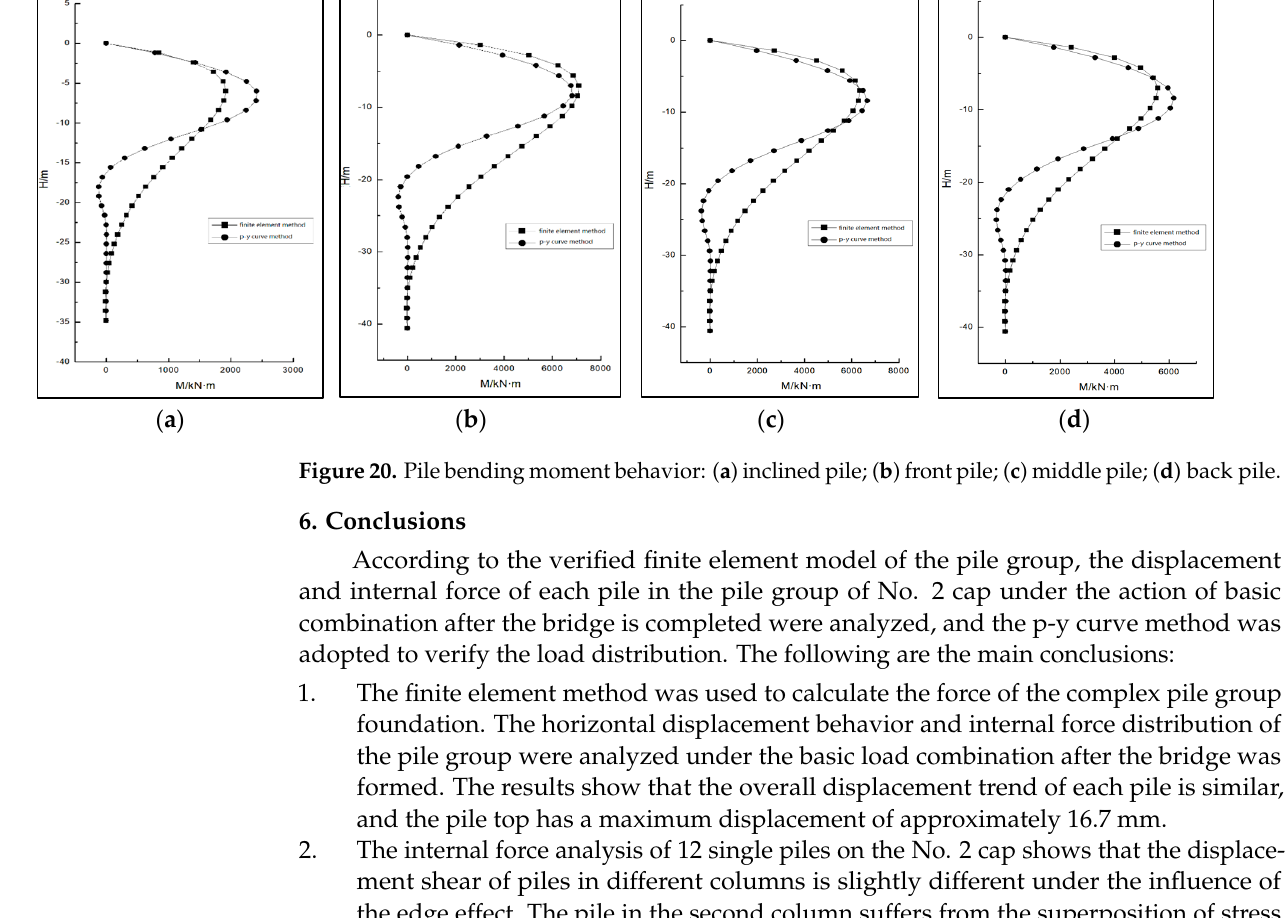
Figure 19. Pile shear force behavior: ( a ) inclined pile; ( b ) front pile; ( c ) middle pile; ( d ) back pile.